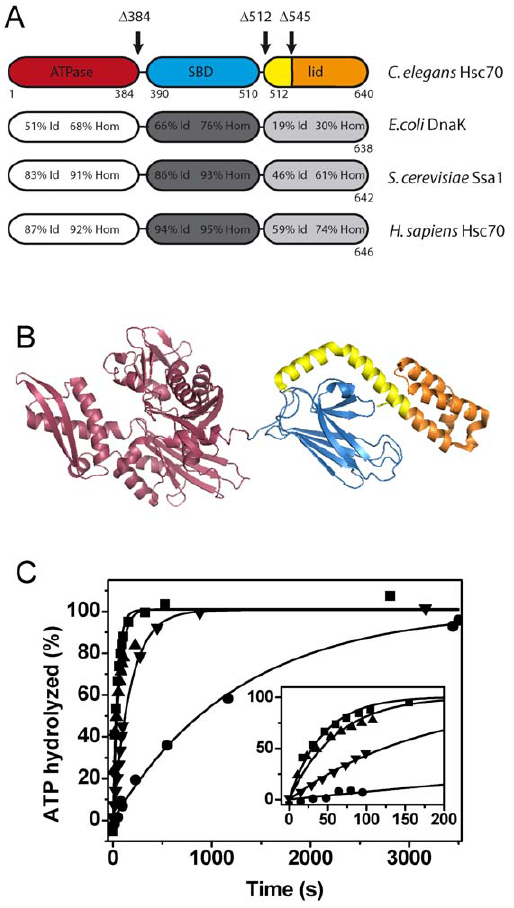
Figure 2. CeHsc70 truncation mutants show an altered ATP turnover. ( A ) Domain organization and amino acid identity (Id) and homology (Hom) of CeHsc70 towards bacterial, yeast and human homologs. The truncation mutants generated in this work are indicated by black arrows. ( B ) Structure of DnaK based on the PDB file 2KHO [93]. The truncations are colored in red (CeHsc70- D 384), red and blue (CeHsc70- D 512) and red, blue and yellow (CeHsc70- D 545). The lid region, which is missing in the CeHsc70- D 545 mutant, is highlighted in orange. ( C ) The single-turnover experiments using 20 m M CeHsc70 variants were performed as outlined in the Material and Methods Figure 3. The function of the NEF BAG-1 is conserved in N section in standard buffer at 25 u C. Data for CeHsc70- D 384 ( . ), context with CeHsc70. ( A ) Domain organization of BAG-1 homologs ) and CeHsc70 ( & ) were fit to CeHsc70- D 512 ( m ), CeHsc70- D 545 ( from C. elegans , H. sapiens and S. cerevisiae . Percentages relate to single exponential functions. The inset shows the initial phase of the identical (Id) and homolog (Hom) residues in respect to the nematode hydrolysis reaction within the first 200 s.